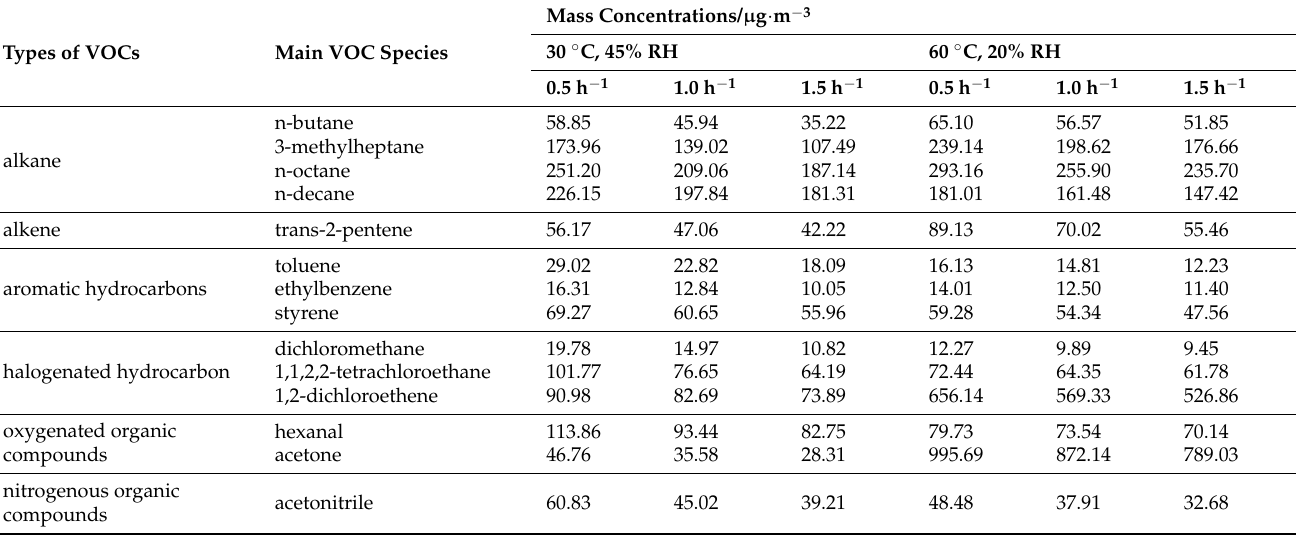
Figure 9. Mass concentrations of VOCs released from plastic track at AERs varying from 0.5 to 1.5 h −1 . Temperature = 60 °C and RH = 20%. Table 4. Mass concentrations of main VOCs released from plastic track under different values of air exchange